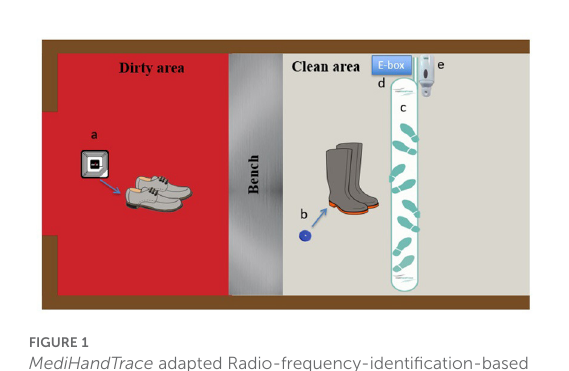
FIGURE1 MediHandTrace adapted Radio-frequency-identification-based (RFID) real-time continuous automated monitoring system. (a) Soft chips inserted in work shoes used by personnel getting to the farm; (b) rigid chips inserted in the soles of farm boots; (c) RFID antenna; (d) MediHandTrace device (e-box) with